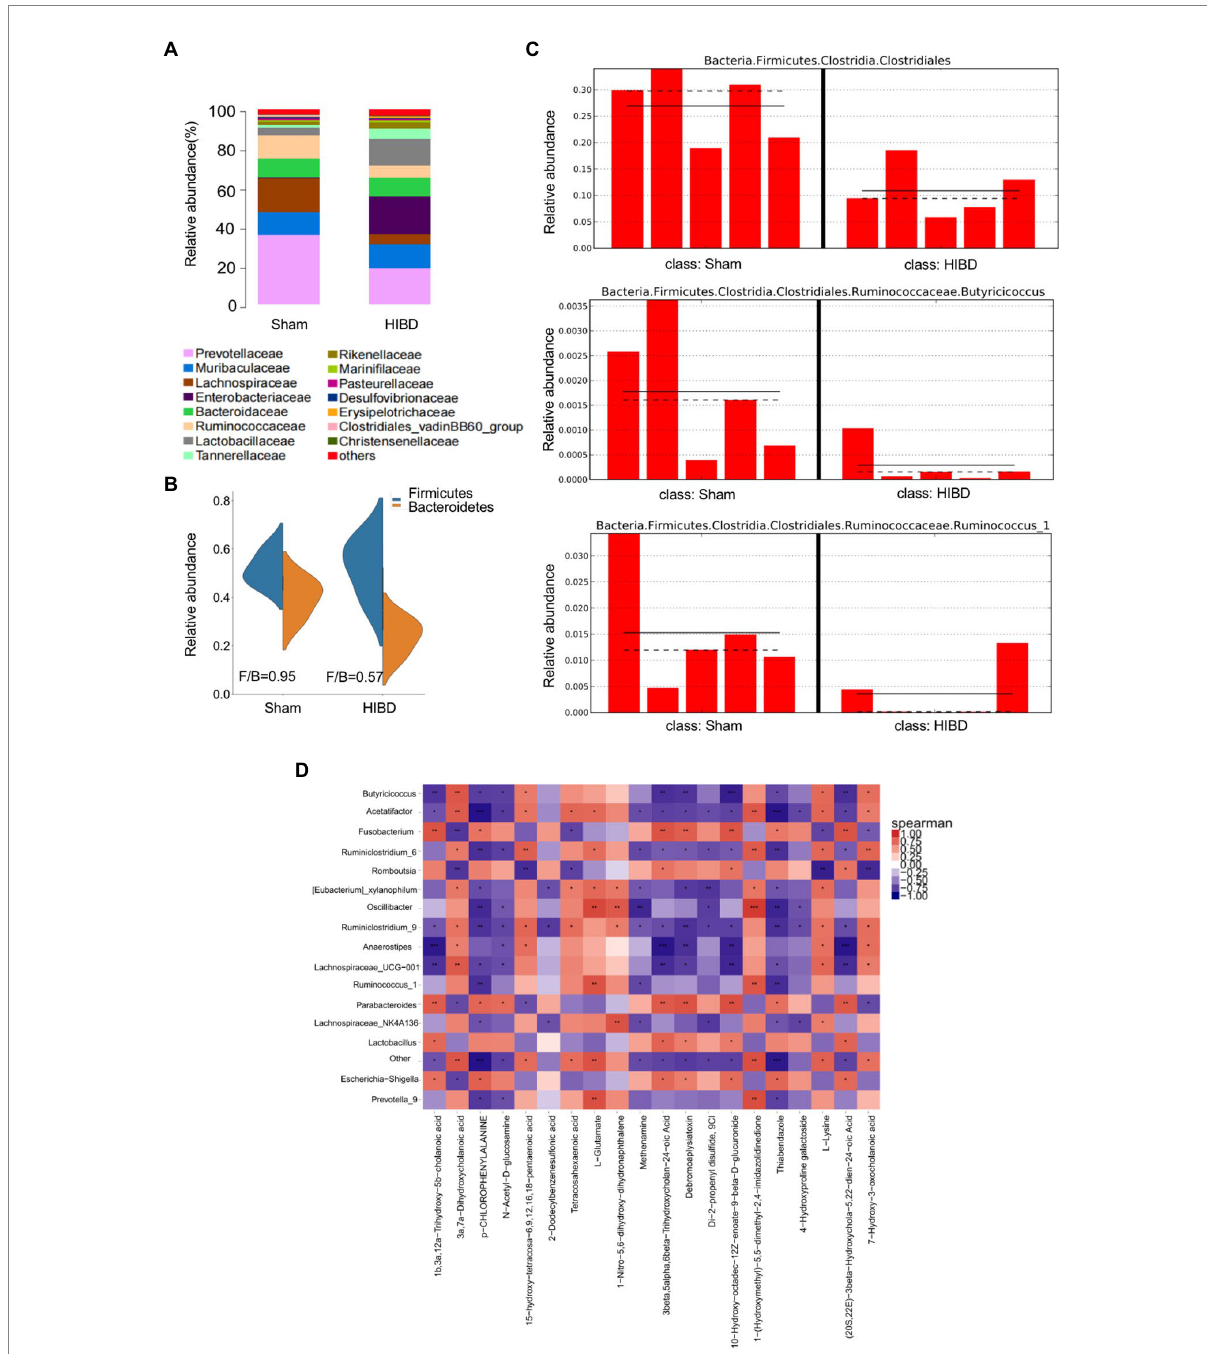
FIGURE 2 ( A ) Taxonomic summary of the gut microbiota of two groups at family level. The abscissa represents the group, and the ordinate represents the relative abundance ( n = 5). ( B ) Firmicutes/Bacteroidetes ratio of the gut microbiota of two groups at phylum level. ( C ) Histogram of relative abundance of short-chain producing bacteria, where the solid line is the average value of relative abundance and the dotted line is the median value of relative abundance. Each column represents the relative abundance of each sample in each group (all LDA threshold value >2.0, n = 5). ( D ) Correlation analysis of metabolomic and microbiome of two groups. The color scale represents the strength of correlation, ranging from 1 (strong positive correlation) to − 1 (strong negative correlation). * p < 0.05, ** p < 0.01, and *** p <